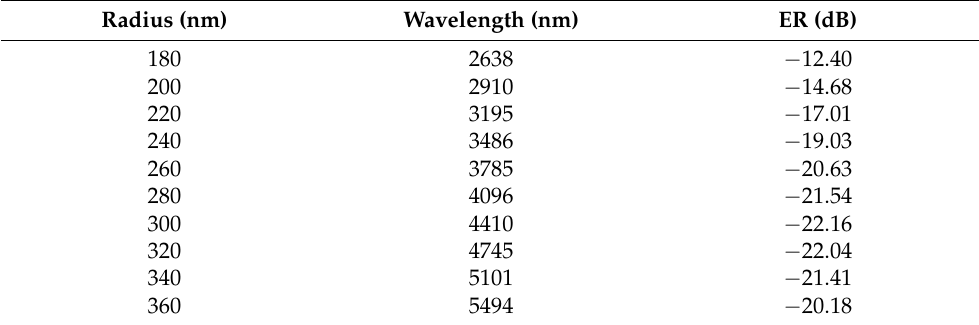
Table 1. Resonance wavelength and extinction ratio of optical switches with different radii.